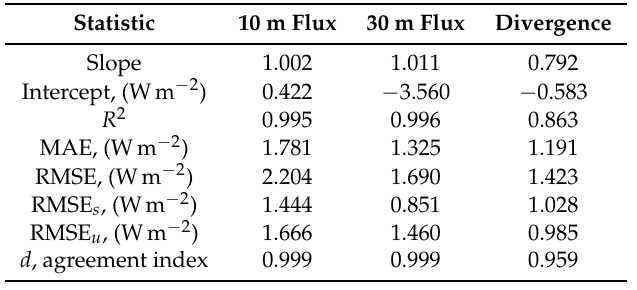
Table 4. Statistical performance of the Payerne evaluation calculated at 30 min intervals over a continuous 14-day period. MAE is mean absolute error. RMSE s and RMSE u represent the systemic and unsystematic root-mean-square error respectively. Statistical tests were selected from [29,30]; n = 378.